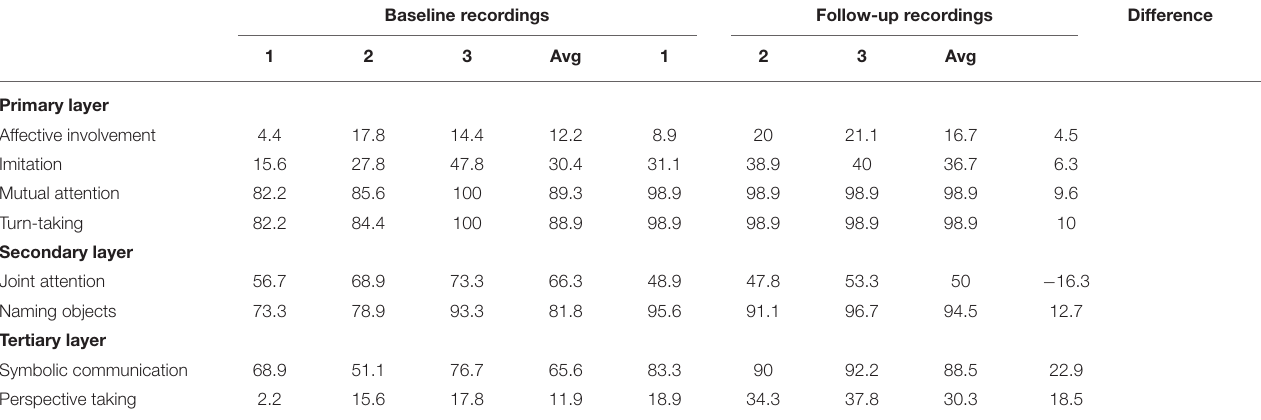
TABLE 9 | Percentage presence of LCM behaviors and difference in presence between baseline and follow-up recordings for dyad 7. Baseline recordings Follow-up recordings